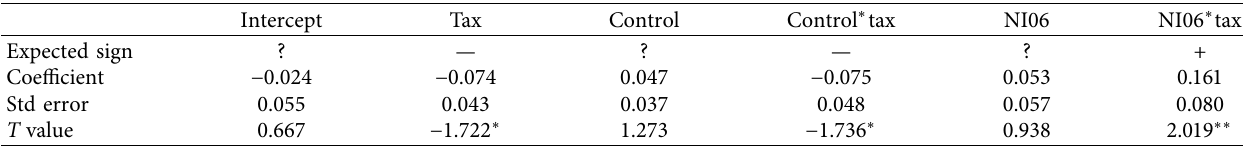
Table 4: The empirical results of portioned model.